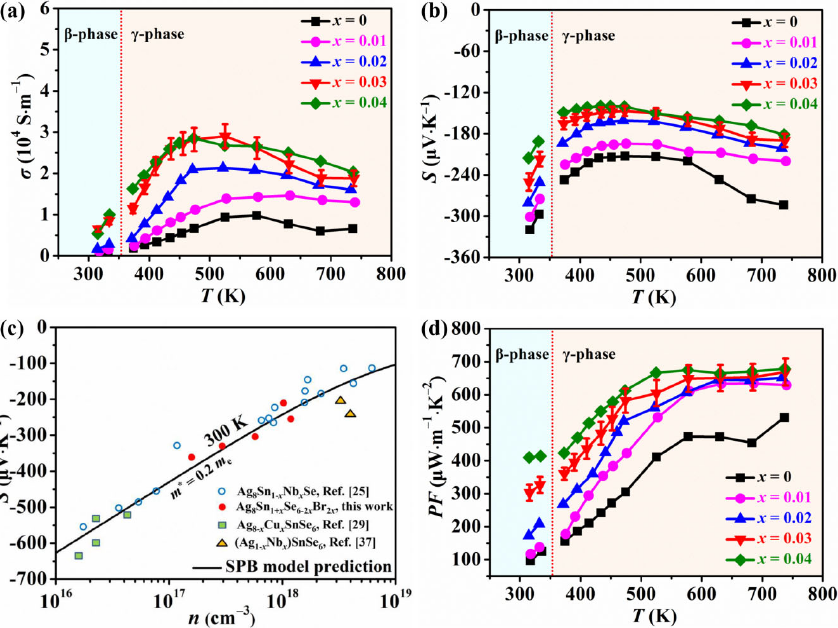
Fig. 4 Temperature dependence of the electrical transport property for Ag 8 Sn 1+ x Se 6 − 2 x Br 2 x ( x = 0, 0.01, 0.02, 0.03, and 0.04): (a) σ , (b) S , (c) the relationship between S and n , and (d) PF